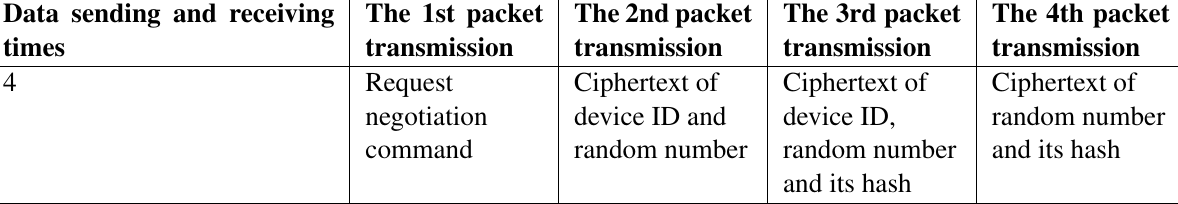
Table 2 Communication overhead of key agreement process